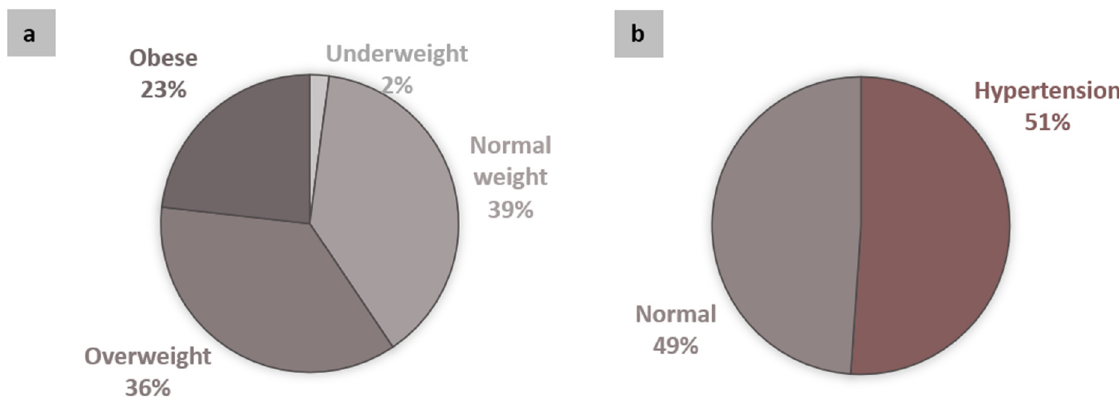
Figure 2. Distribution of nutritional status ( a ) and prevalence of hypertension (SBP ≥ 130 mm Hg and/or DBP ≥ 85 mm Hg) ( b ) in the participants ( n = 818).